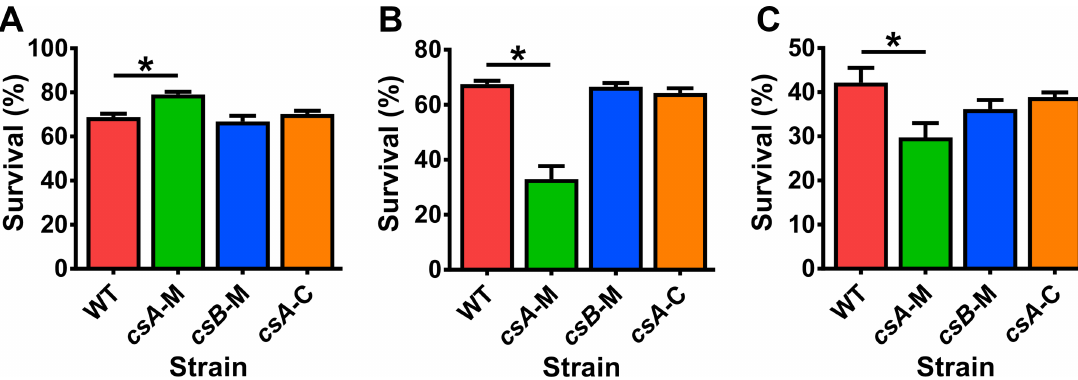
Fig 4. Spores of the csA mutant have altered heat and chemicals resistance properties compared to wild-type spores. Spores were treated to 75˚C heat (A), 0.5 M hydrochloric acid (B) and 0.15 M sodium hydroxide (C) for 30 minutes after which the spores were incubated on HIS agar to determine the percentage of spore survival. The results represent the average of four independent experiments and error bars represent standard error of the mean. Asterisks indicate statistical difference at p (cid:20) 0.05. Wild-type, WT; csA mutant, csA - M; csB mutant, csB- M; csA mutant complemented, csA